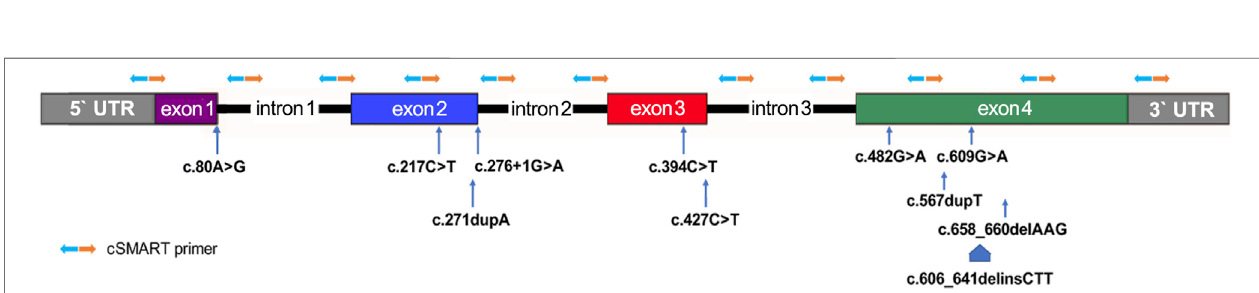
FIGURE 1 | Study design. Trio gene testing to identify pathogenic MMACHC mutations. IPD and NIPT were performed to assess fetal genotypes in second pregnancies.